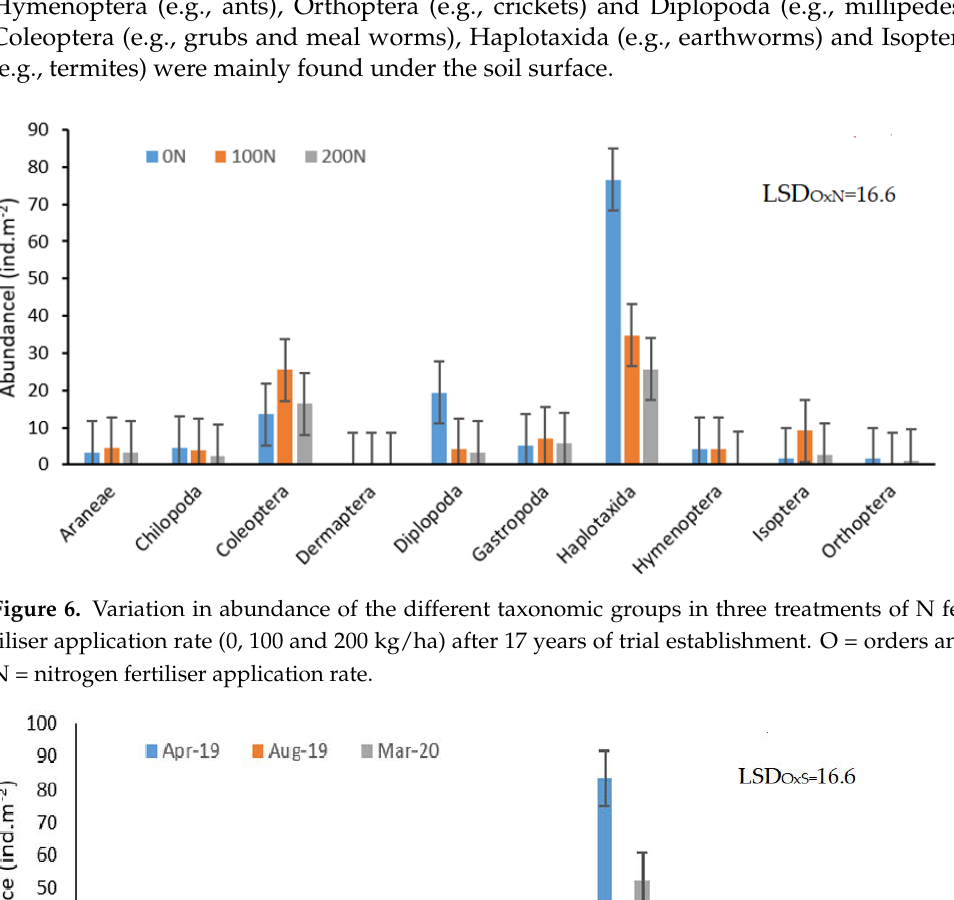
Table 6. The results of repeated ANOVA of the effect of treatments (NT, RT and CT), sampling time